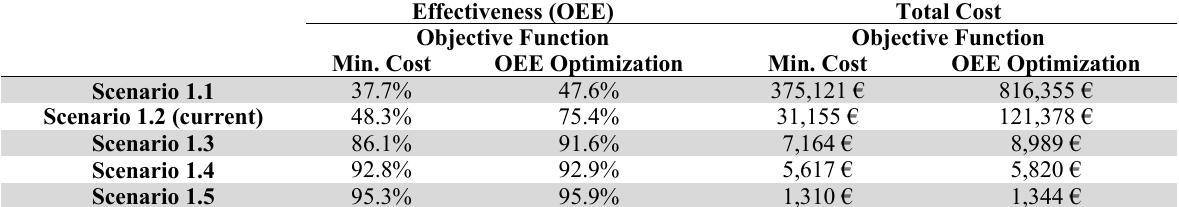
Effectiveness and cost for sensitivity analysis 1 Effectiveness (OEE) Total Cost Objective Function Objective Function Min. Cost OEE Optimization Min. Cost OEE